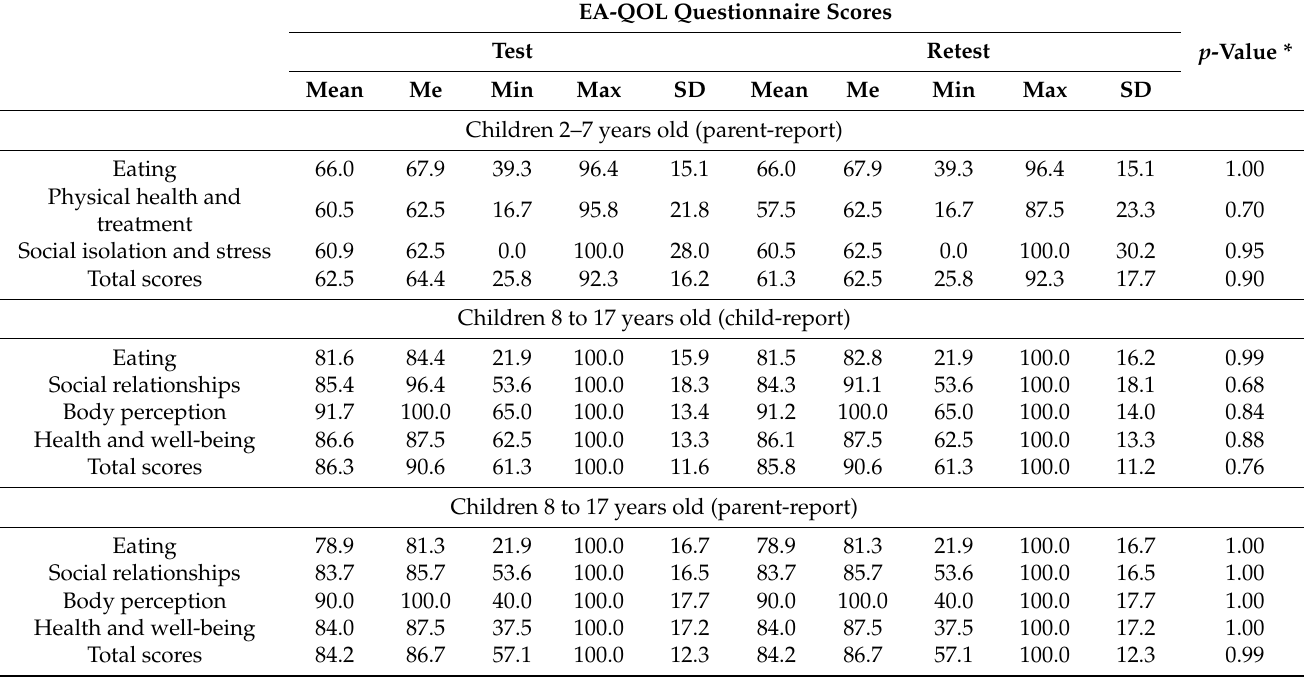
Table 4. Comparison of the EA-QOL questionnaire scores in the “test” and “retest” study. EA-QOL Questionnaire Scores